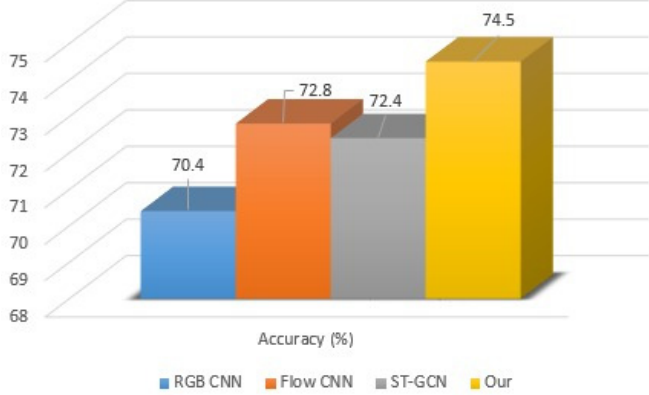
Figure 7. Accuracy comparison with other methods using the SUB Kinetic Interaction dataset.